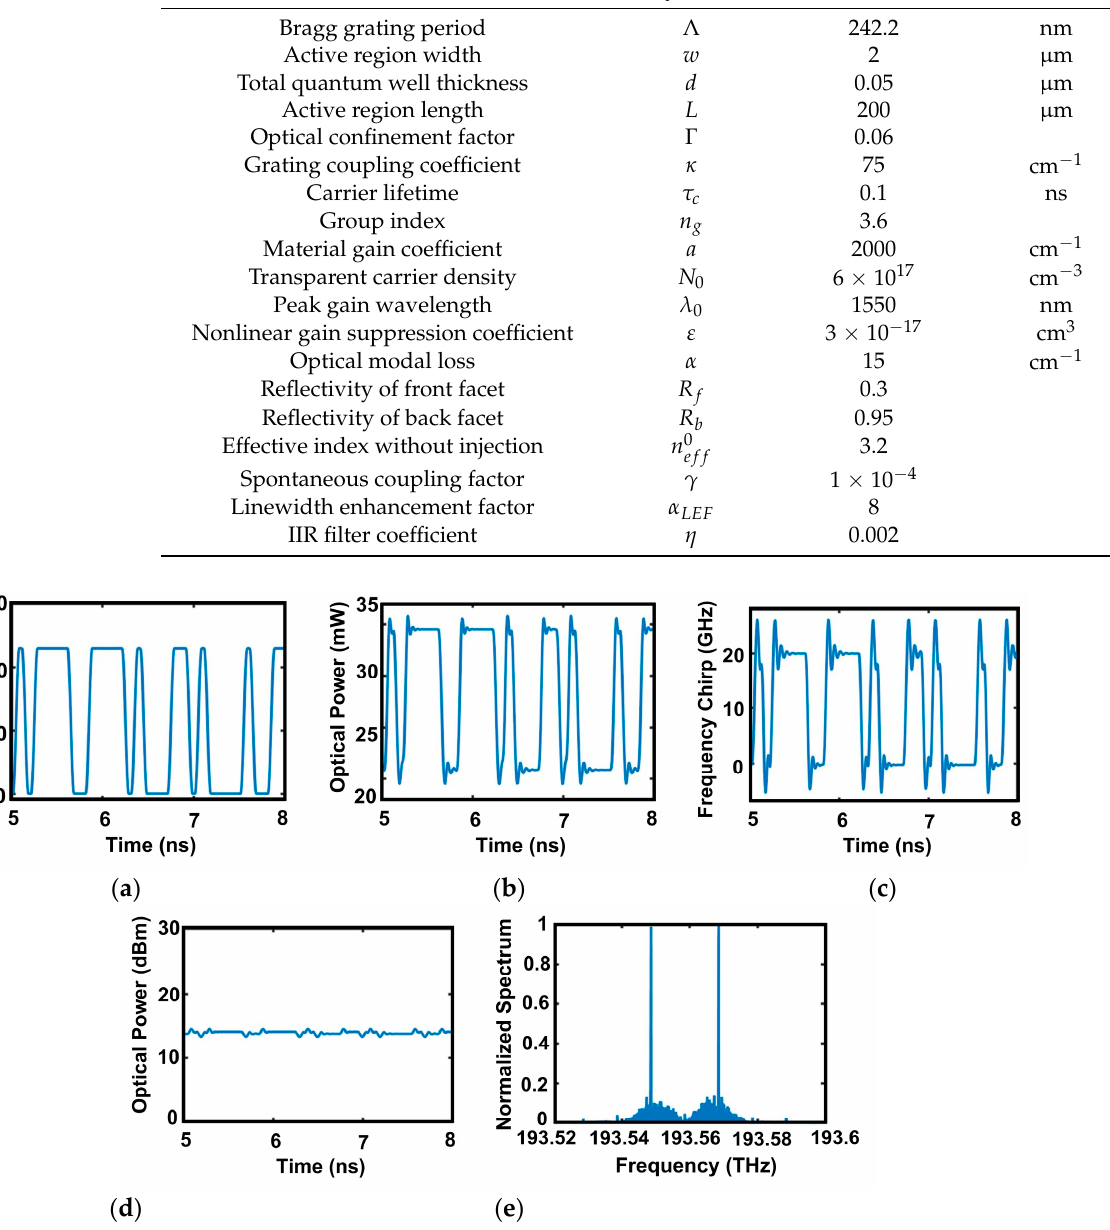
Figure 2. Characteristics of the FM transmitter: ( b ) the output optical power and ( c ) frequency chirp of the directly modulated DFB laser with ( a ) the signal current applied, ( d ) the optical power, and ( e ) the spectrum of the optical signal after passing through the SOA.